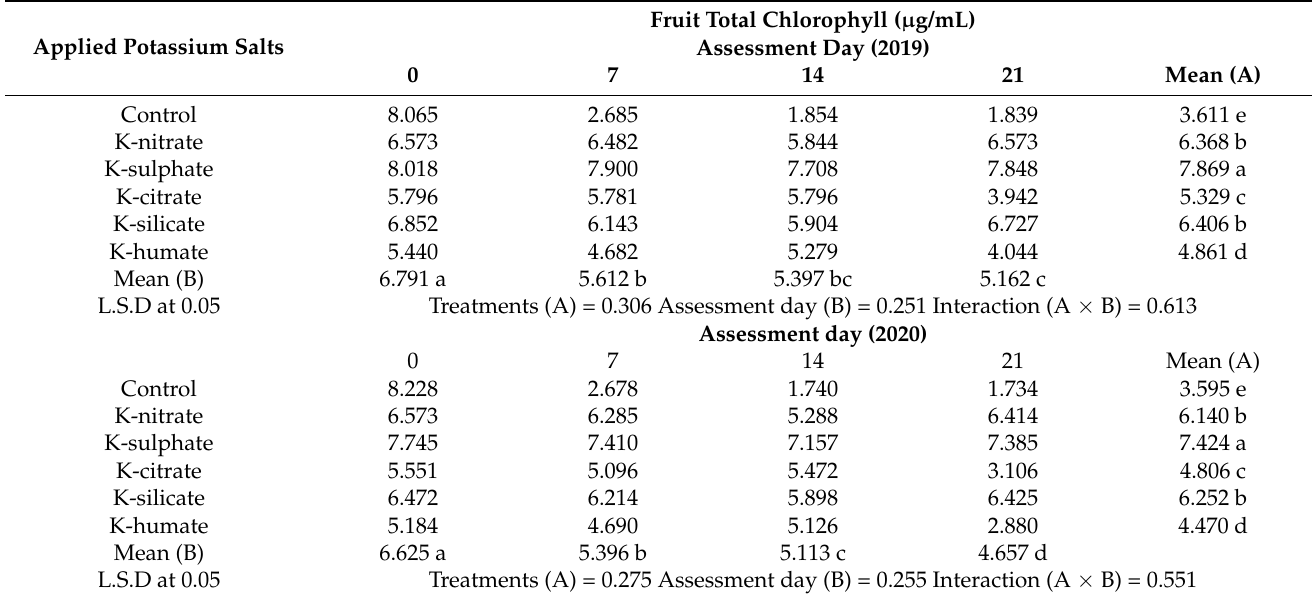
Table 4. Effect of diverse potassium forms as foliar application on total chlorophyll ( µ g/mL) of apricot fruits cv. ‘Canino’ in 2019 and 2020 seasons during cold storage 0 ± 1 ◦ C and 90 ± 5%